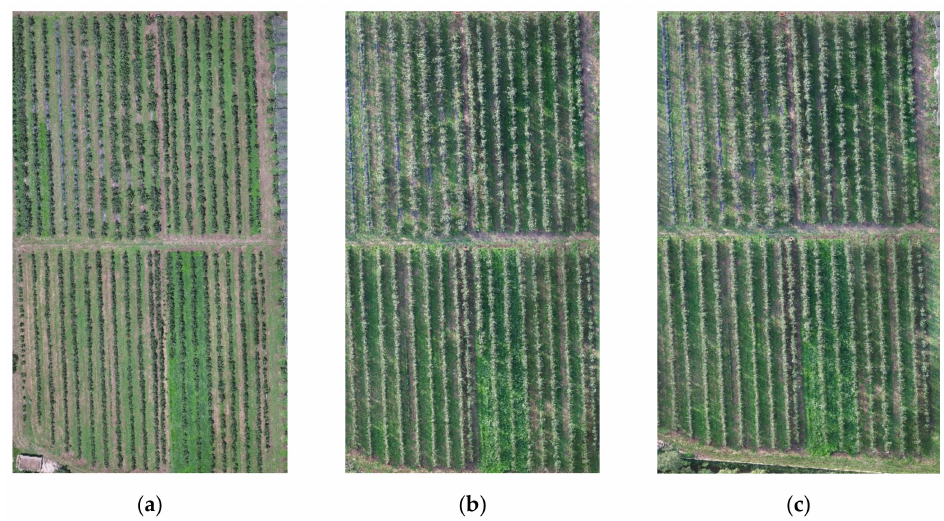
Figure 5. Changes in the apple tree growth patterns in Zone A during: ( a ) the fruit expansion stage, ( b ) the leaf differentiation stage, and ( c ) the shoot-stopping stage.